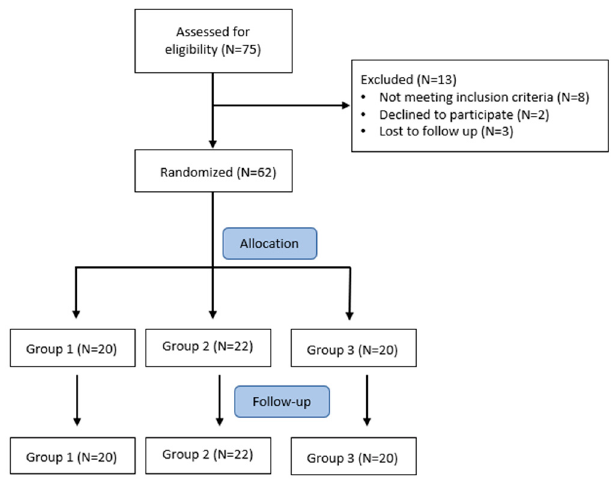
Figure 1. Flow diagram of patient selection in the study. Table 1. Baseline characteristics of Group 1 (treated with ferrous sulfate), Group 2 (treated with ferric sodium EDTA in combination with vitamin C, folic acid, copper gluconate, zinc gluconate, and selenomethionine), and Group 3 (treated with liposomal iron).